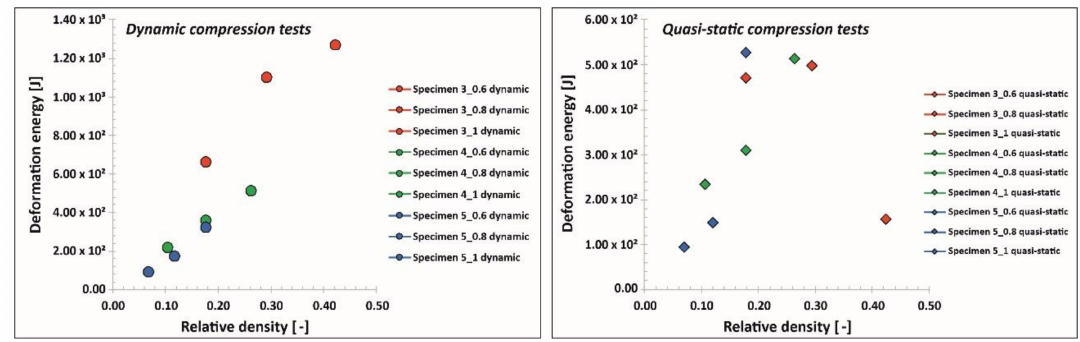
Figure 27. Comparison of the maximum deformation energy values under quasi-static and impact loading